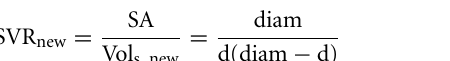
of 0.1 μ m. P-type Ca 2 + channel with P max of 5 . 2 × 10 − 5 cm/s was used for Ca 2 + influx. Inset: comparison of peak amplitudes of Ca 2 + transients using SP old and SP new show that the first mechanism causes exactly the same transient in all compartments, whereas, SP new causes transients with varying peak Ca 2 + amplitudes. (D) Error in peak Ca 2 + levels caused by using the SP old mechanism [error = (max([Ca 2 + ] SP_old ) − max([Ca 2 + ] SP_new )/max([Ca 2 + ] SP_new ))]. Pool models used β -values of 0.02, 6.86, and 10ms − 1 ; and depth (d) values of 0.05, 0.1, 0.15, 0.2, and 0.25 μ m. The lower edge of shaded areas of each color shows error in peak calcium for β -value of 10ms − 1 , whereas, the upper edge of shaded areas of each color show error for β -value of 0.02ms − 1 . The colored asterisks show corresponding error for β -value (used to model PC dendrites) of 6.86ms − 1 . Inset highlights large errors for branches with small diameters (diam ≤ 1 μ